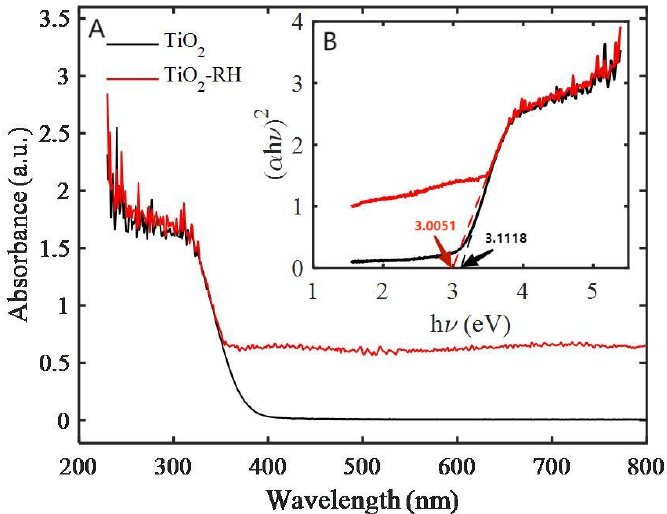
Figure 6. ( A ) UV–vis absorption spectra, ( B ) Tauc’s profile for the band-gap